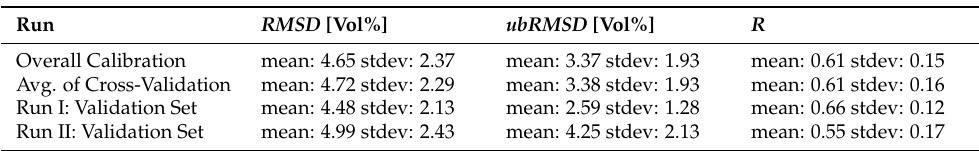
Table 3. Calibration results of API depletion factors and averaged evaluation metrics for overall calibration and calibration in the cross-validation scheme (no masking